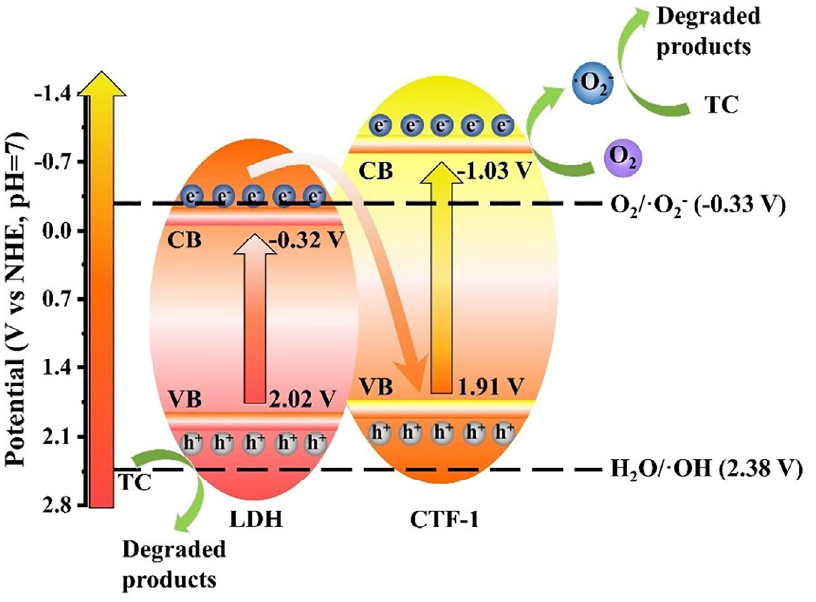
Figure 11. The photocatalytic mechanism for the degradation of TC on Z-Scheme LDH/CTF-1 het- erostructures.